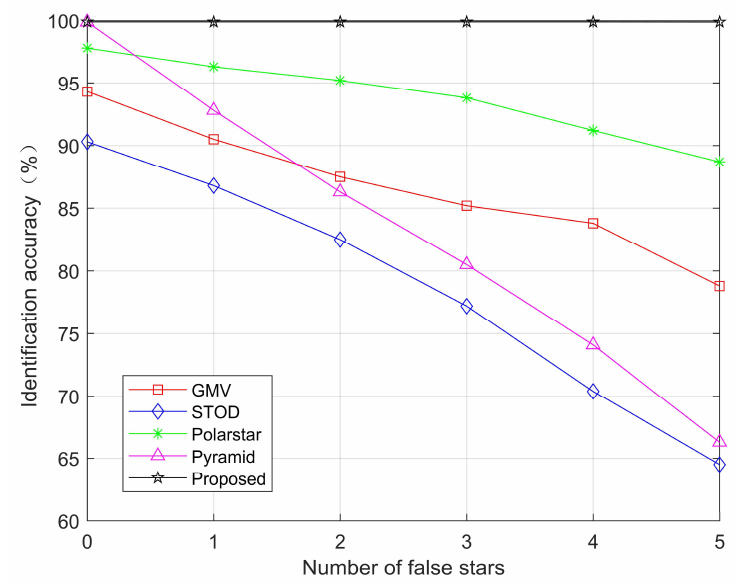
Figure 23. Identification accuracy benchmarking for sensitivity to false stars.